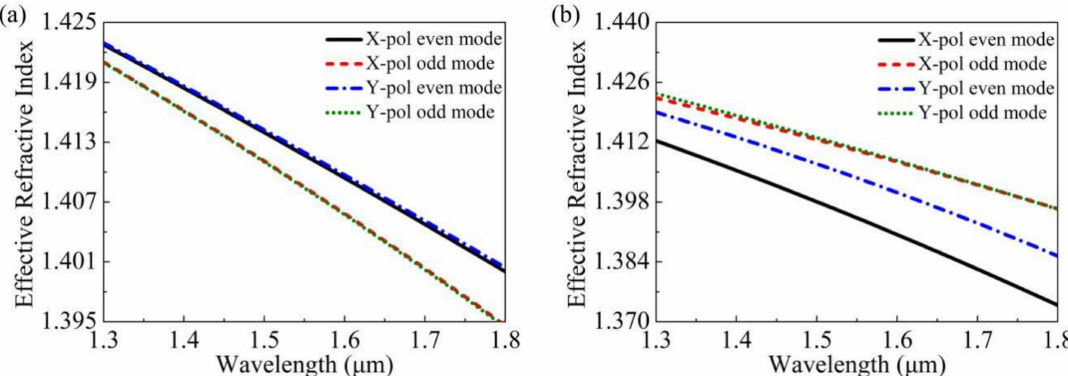
Figure 2. The effective refractive indices of the X-pol and Y-pol even and odd modes of the LC-DC-PCF when the LC-DC-PCF is filled ( a ) without and ( b ) with LC E7, respectively.